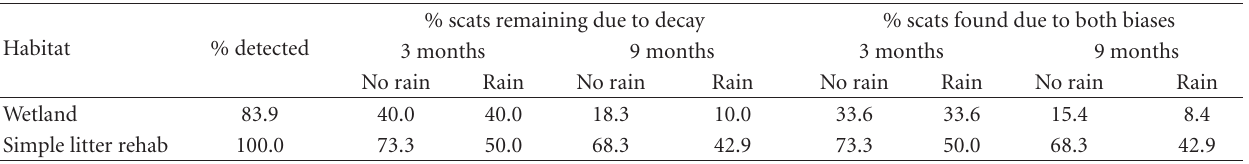
Table 7: Comparison of the percentage of predicted scat recovery in two extreme vegetation communities based on observed detectability and decay